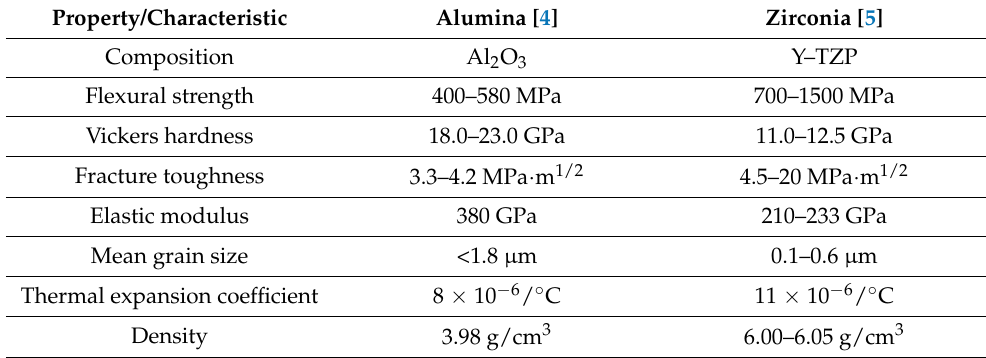
Table 1. Properties of Al 2 O 3 and yttrium-stabilized tetragonal ZrO 2 (Y-TZP) ceramics. Property/Characteristic Alumina [4]